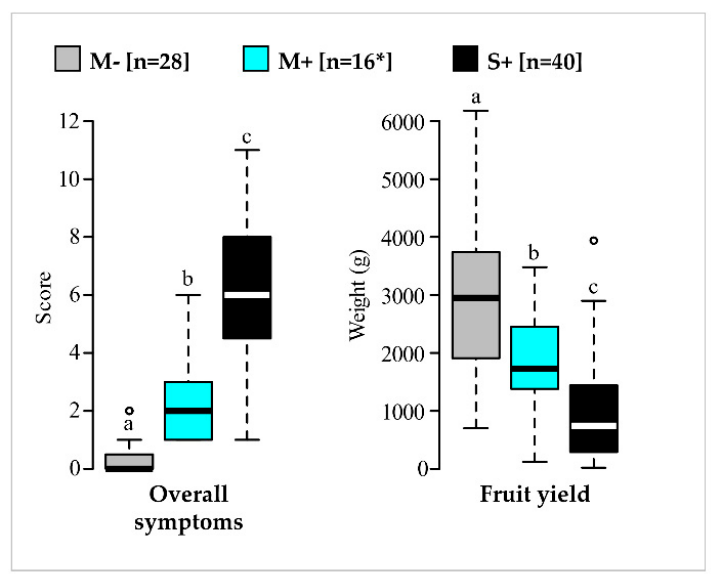
Figure 4. Comparison of overall symptom scores and fruit yields over four years for vines in M − , M+ and S+ categories. Results for vines in the M − (in grey), M+ (in cyan) and S+ (in black) categories are shown. Boxplots show the median (horizontal bold line) and the interquartile range with lonely dots representing extreme data. Different letters (a,b,c) indicate significant differences ( p ≤ 0.05). Raw data and results of the statistical tests are available in Tables S1 and S3, respectively. Number of vines (n) is given in brackets. * For the M+ category, 15 replicates were considered for overall symptom scores.